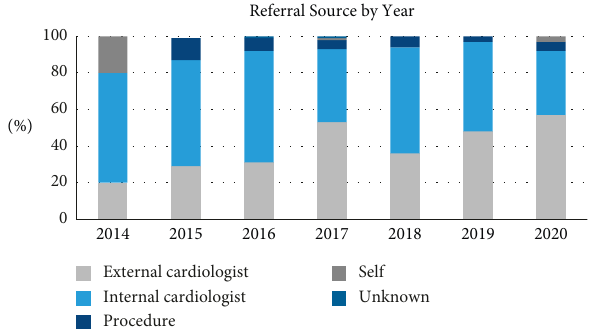
Figure 1: Referral source by year for all TAVRs performed at a single